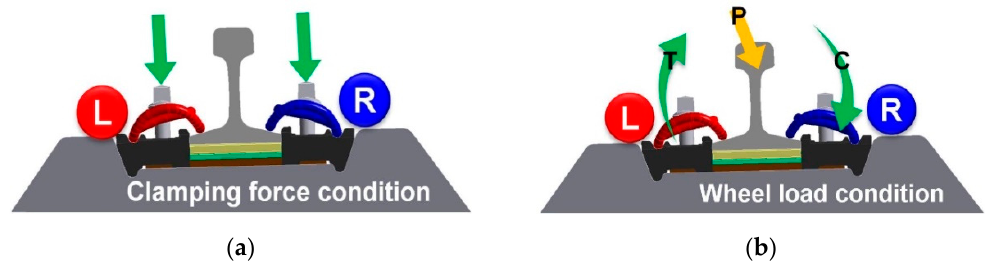
Figure 11. Conceptual diagram of the loading action of tension clamp. ( a ) Application of clamping force. ( b ) Application of curved track force.